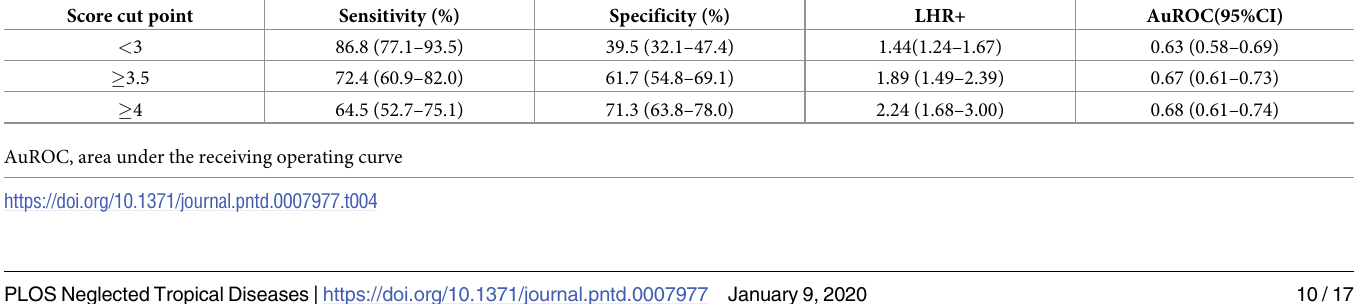
Table 4. Selection of score cut point, sensitivity, specificity, LHR+, AuROC. Score cut